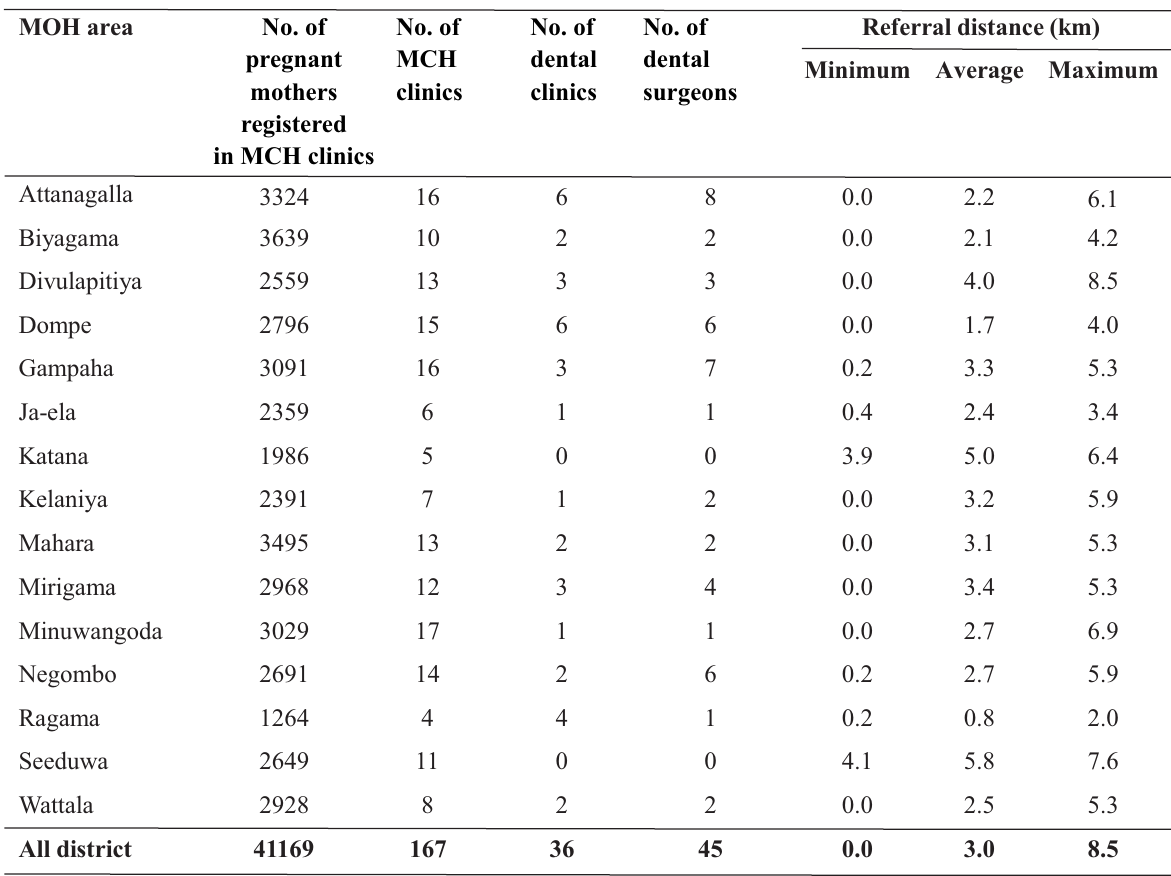
Table 1: Number and percentage of MCH clinics having their nearest dental clinic at different distance levels Referral Distance